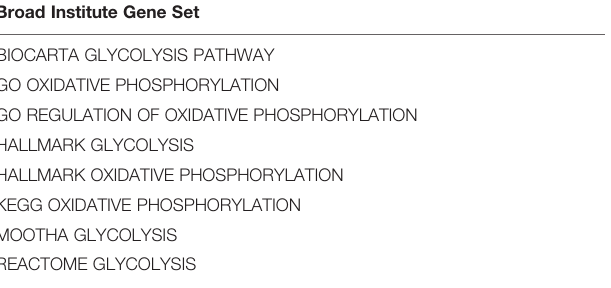
TABLE 1 | Gene sets used to study glucose metabolism at gene expression